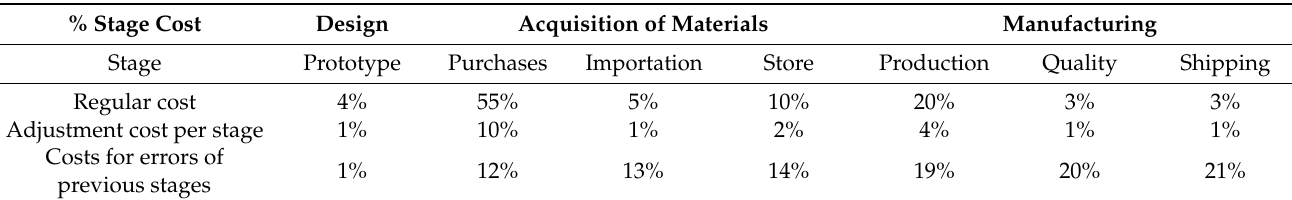
Table 1. Rework costs in the enterprise.